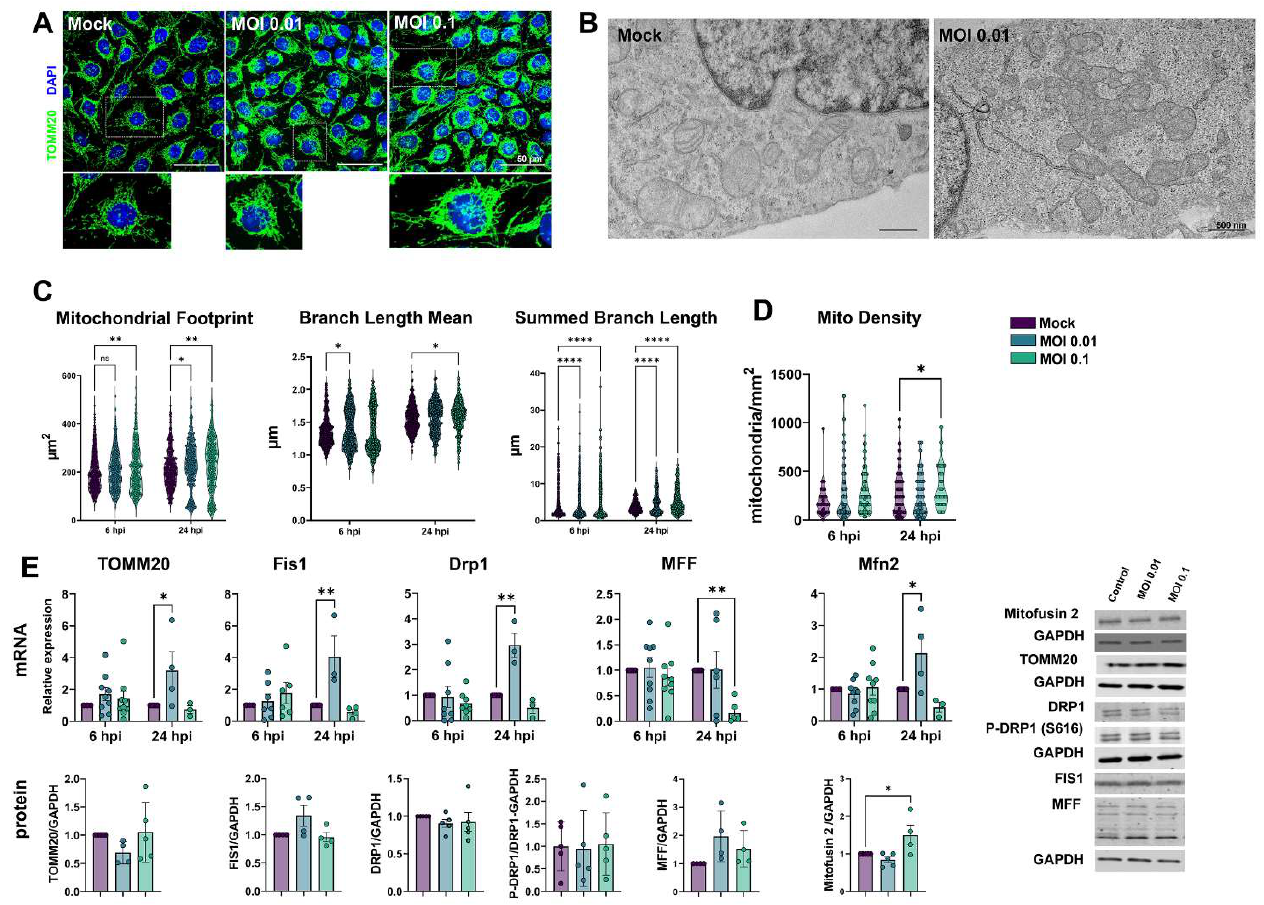
Figure 5. SARS-CoV-2-induced mitochondrial remodeling in HBMECs. Mitochondrial networks were detected by TOMM20 immunostaining ( A ) and TEM ( B ). MiNA analysis of TOMM20 revealed that exposure to SARS-CoV-2 induced an increase in mitochondrial footprint, branch length mean, and summed branch length ( C ). Mitochondrial density was calculated by TEM images ( D ), which also revealed increased fusion and association with multivesicular bodies ( B ). ( E ): RT-qPCR ( upper panel ) and western blotting ( lower panel ) analyses revealed that although fission-related genes (Fis1 and Drp1) were up-regulated in MOI 0.01-exposed cultures, only Mfn2 protein levels were increased in MOI 0.1-exposed cultures. TOMM20 protein levels also remained unaltered. *: p < 0.05; **: p < 0.01; ****: p < 0.0001, two-way ANOVA with Bonferroni post-test. Each symbol in graphs represents one cell ( C ), one mitochondrion ( D ), or one independent experiment ( E ). Bottom right panels depict blots from ( E ). Scale bars: 50 µ m for ( A ) and 500 nm for ( B ).